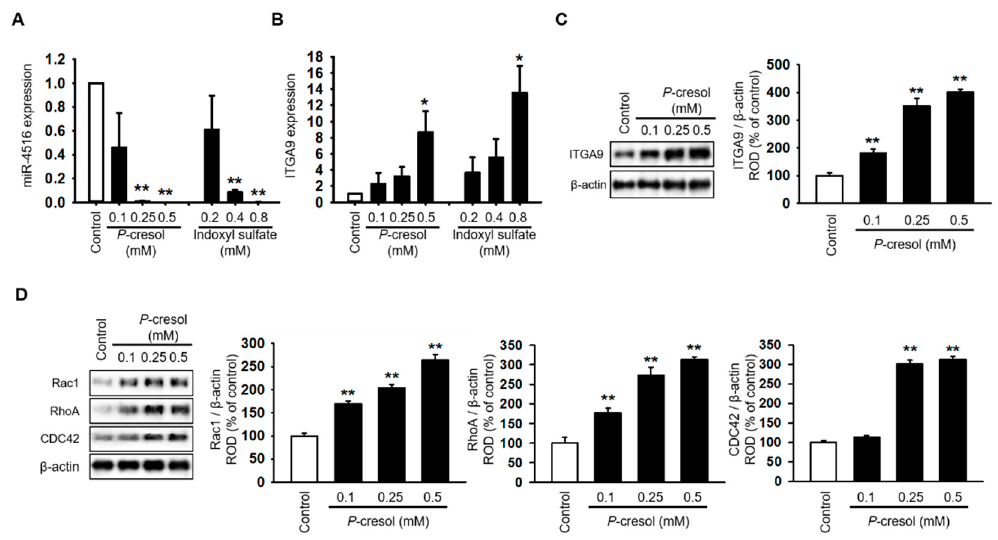
Figure 2. Cytoskeleton reorganization and ITGA9-Rho GTPase signaling pathways are activated due to decreased miR-4516 expression following P -cresol exposure. ( A , B ) Expression of miR-4516 and ITGA9 was detected in human proximal tubular epithelial (TH1) cells with P -cresol (0.1, 0.25, and 0.5 mM) or indoxyl sulfate (0.2, 0.4, and 0.8 mM) exposure for 72 h ( n = 3). The values represent mean ± SEM. * p < 0.05, ** p < 0.01 vs. control. ( C , D ) Western blot analysis for ITGA9, Rac1, RhoA, and CDC42 in TH1 cells after exposure to various doses of P -cresol (0, 0.1, 0.25, and 0.5 mM) for 72 h ( n = 3). Protein expression was determined by densitometry relative to β -actin. The values represent mean ± SEM. ** p < 0.01 vs. control.